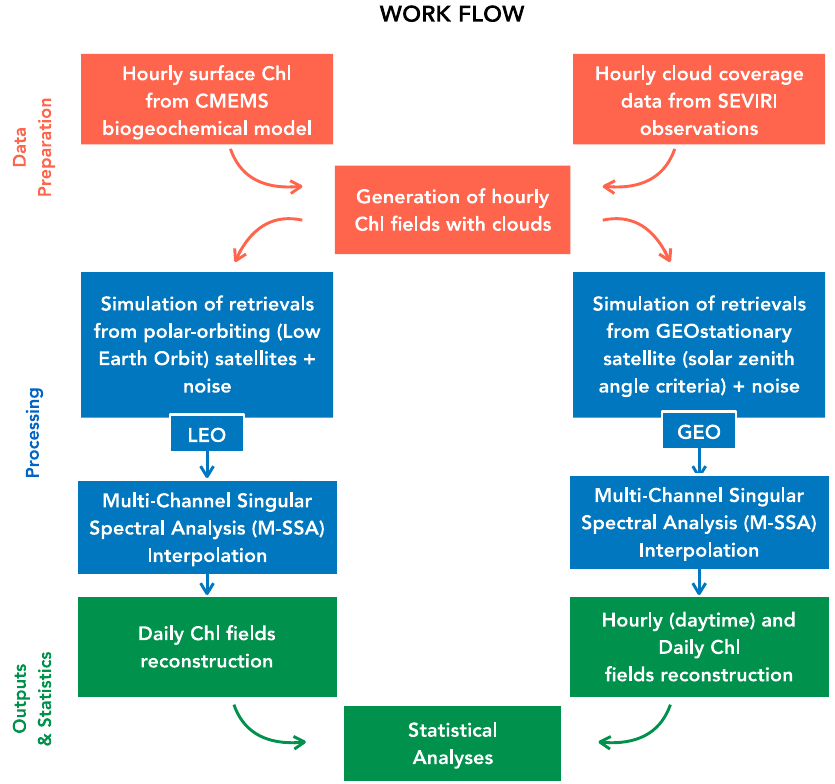
Figure 1. Flowchart diagram of the method developed in this paper. Orange represents dataset preparation, blue represents the processing of data, and green represents the outputs and statistical analyses.